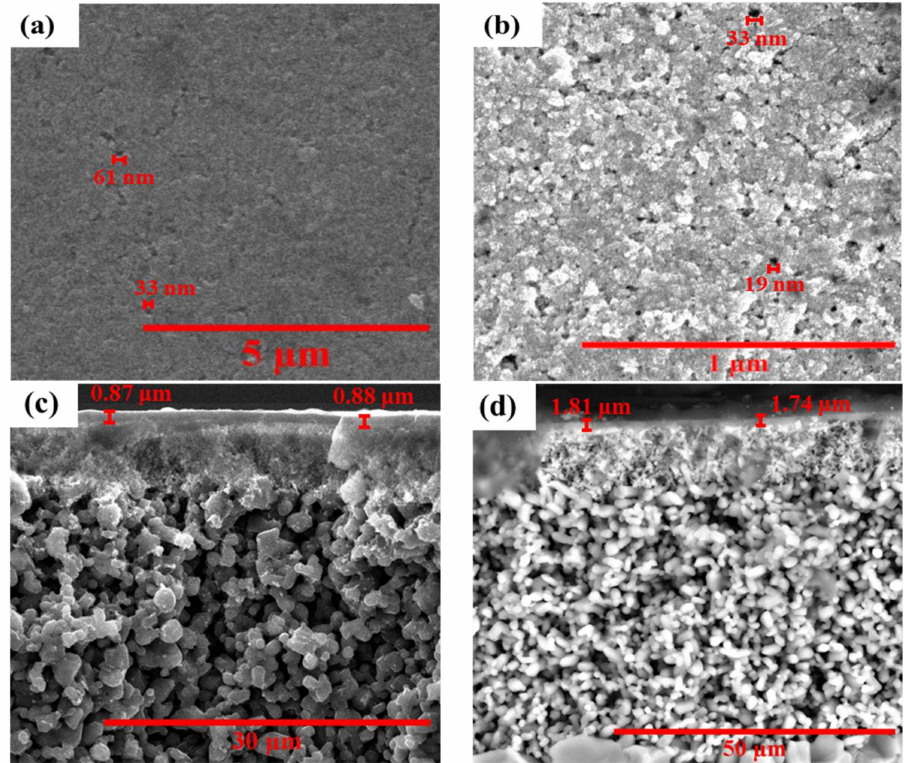
Figure 4. FESEM micrographs on the surface of ( a , b ) CSCM and CSGOM, and ( c , d ) cross section of CSCM and CSGOM (CSCM: 10% wt. Matrimid and CSGOM: 1 mg · L − 1 GO